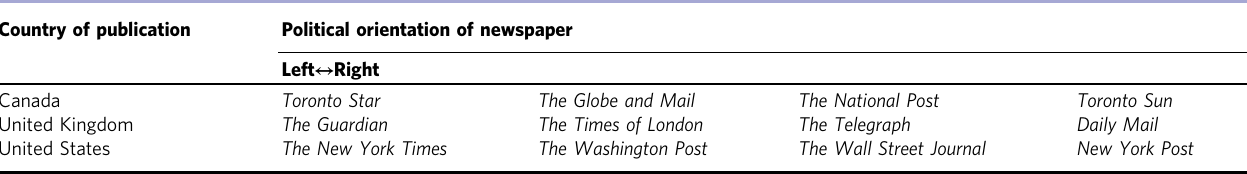
Table 1 News media outlets studied, by country of publication and political